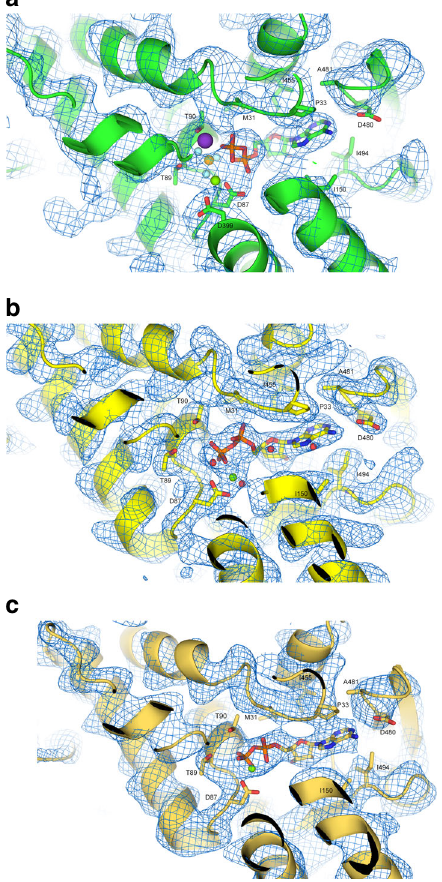
Fig. 2 Nucleotide state of the complexes. a ADP:BeF 3 -bound football complex. Electron-density omit map at 1 σ and the atomic model are shown around the nucleotide-binding site with one bound ADP molecule and BeF 3 . Selected residues in the nucleotide binding pocket are indicated. The Mg 2 + ion is marked as a green sphere, K + as purple, and BeF 3 as gold surrounded by cyan spheres. b ADP-bound football complex. Details of the cryo-EM density and the atomic model around the nucleotide-binding site with one bound ADP molecule are shown. Selected residues in the nucleotide binding pocket are indicated. The Mg 2 + ion is marked as a green sphere, and water molecules are represented as red spheres. c ADP-bound half- football complex. Details of the cryo-EM density and the atomic model around the nucleotide-binding site with one bound ADP molecule. Selected residues in the nucleotide-binding pocket are indicated. The Mg 2 + ion is marked as a green